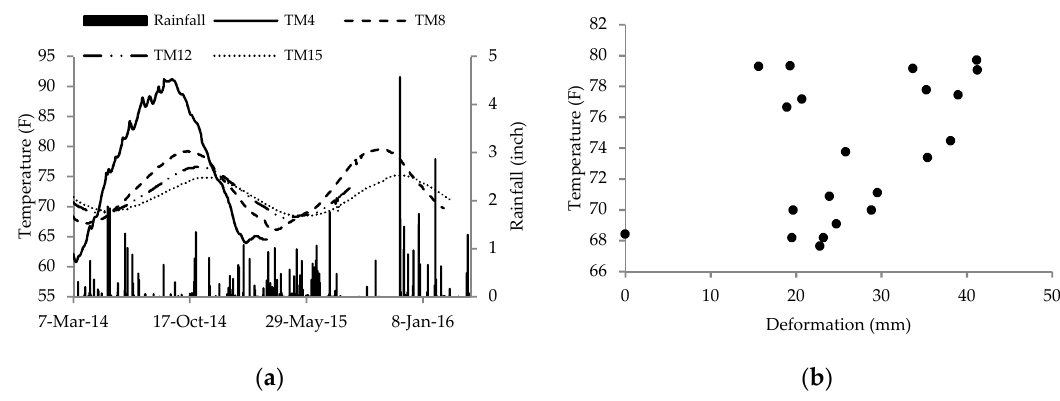
Figure 12. ( a ) Temperature variation in SH 342 site, and ( b ) Temperature and deformation plot for model development.